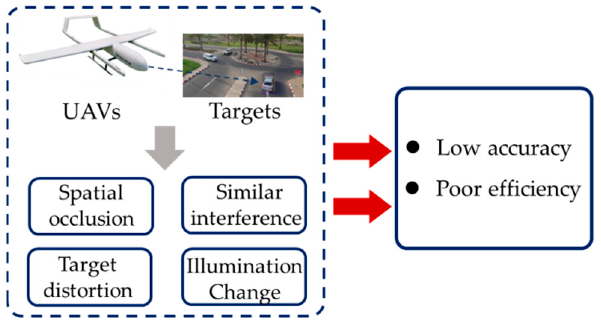
Figure 1. The issues for unmanned aerial vehicles (UAVs).